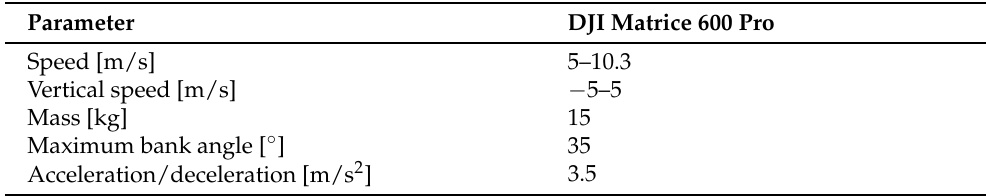
Table 1. Performance data for DJI Matrice 600 Pro used in the simulations of this study.